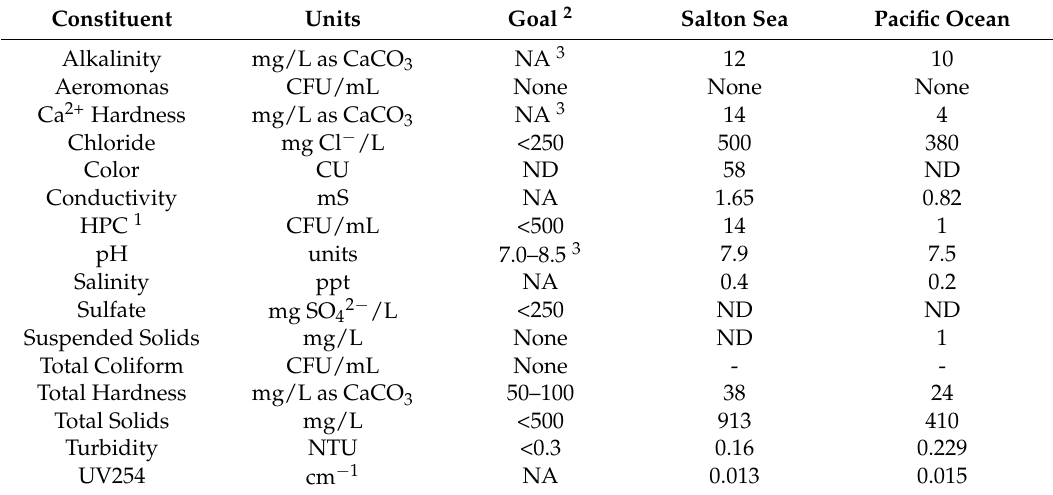
Table 6. RO Permeate Quality Compared to Typical Drinking Water Quality Goals 1